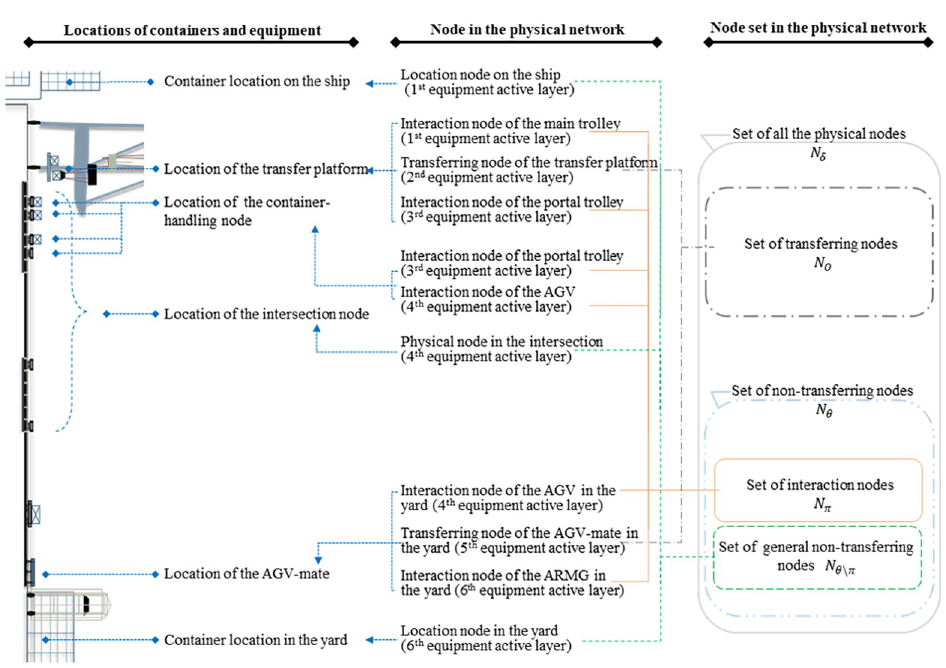
Fig 3. The node and the node set in the physical